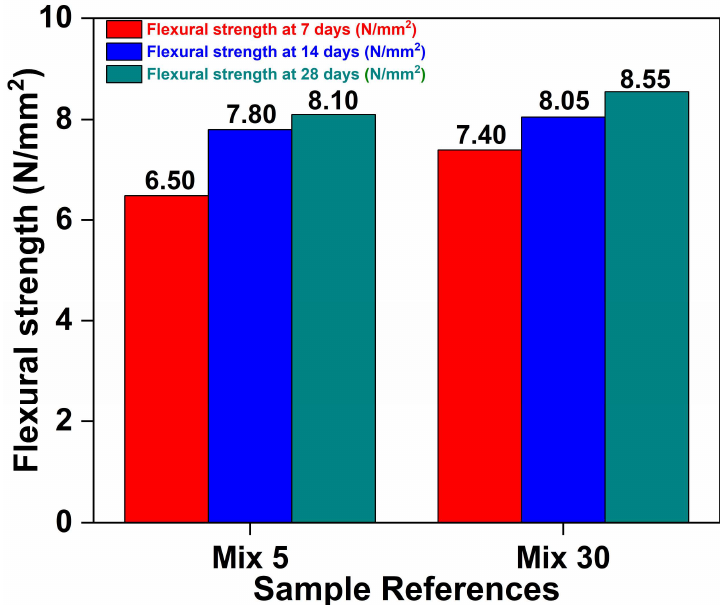
Figure 7. Flexural strength at 7, 14 and 28 days of curing age.